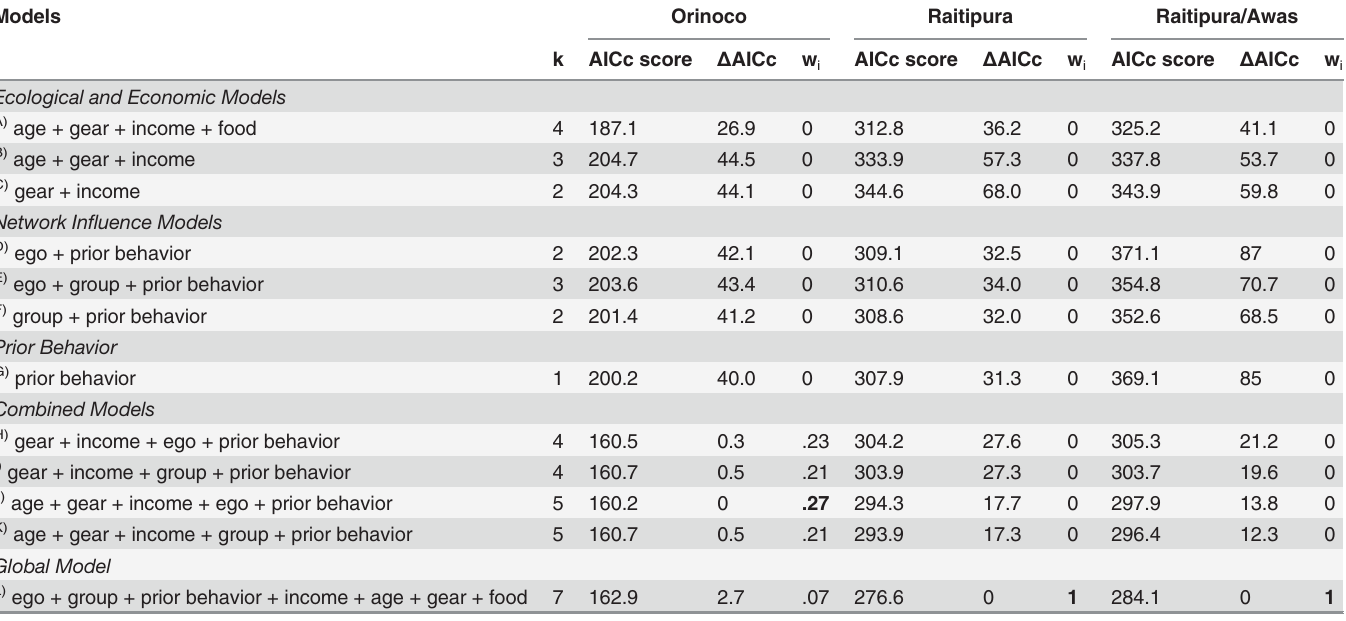
Table 4. Model selection results of the influence of a fisherman ’ s friends network on enforcement behavior. 1